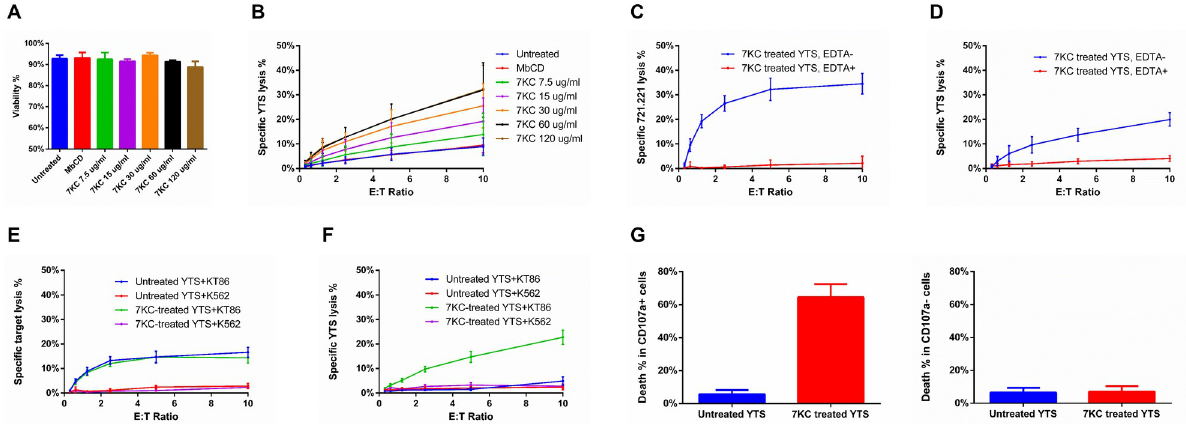
Fig 3. 7KC-induced NK cell death requires target cell–induced NK cell degranulation. (A) Survival of YTS cells after a 4-h incubation in the absence of target cells over a range of 7KC concentrations was measured based on their uptake of PI by flow cytometry to evaluate any direct toxicity of 7KC. (B) The same range of 7KC concentrations was also used as pretreatment of 51 Cr-labeled YTS cells that were incubated with 721.221 target cells over a range of effector to target cell ratios for 4 h. The release of 51 Cr was measured in both sets of experiments at 4 h. Cytotoxicity (C, p < 0.05) and survival (D, p < 0.05) of 7KC-pretreated YTS cells, with or without EDTA (10 mM) calcium chelation, were measured after a 4-h incubation with 51 Cr-labeled 721.221 target cells. Cytotoxicity mediated by (E, p < 0.05) and survival (F, p < 0.05) of 7KC-pretreated YTS cells were measured after a 4-h incubation with nontriggering K562 cells or triggering KT86 cells. Viability (G) of untreated and 7KC-pretreated YTS cells with or without up-regulated LAMP-1 after a 4-h incubation with 721.221 cells was evaluated using flow cytometry with PI used to detect cell death. All data represent averages from 3 independent experiments, and error bars show ± SD (A − E). Wilcoxon signed rank test was used for the comparison between curves. NK, natural killer; PI, propidium iodide; 7KC, 7-ketocholesterol.